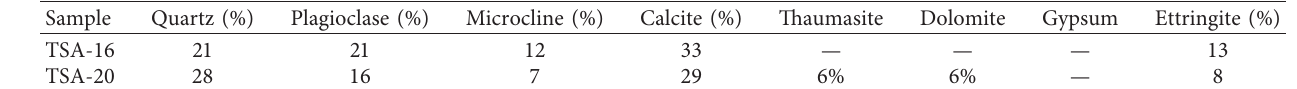
Figure 13: FTIR spectrum of concrete suffered from sulfate attack in tunnel environment. Table 3: Components of corrosion products of damaged